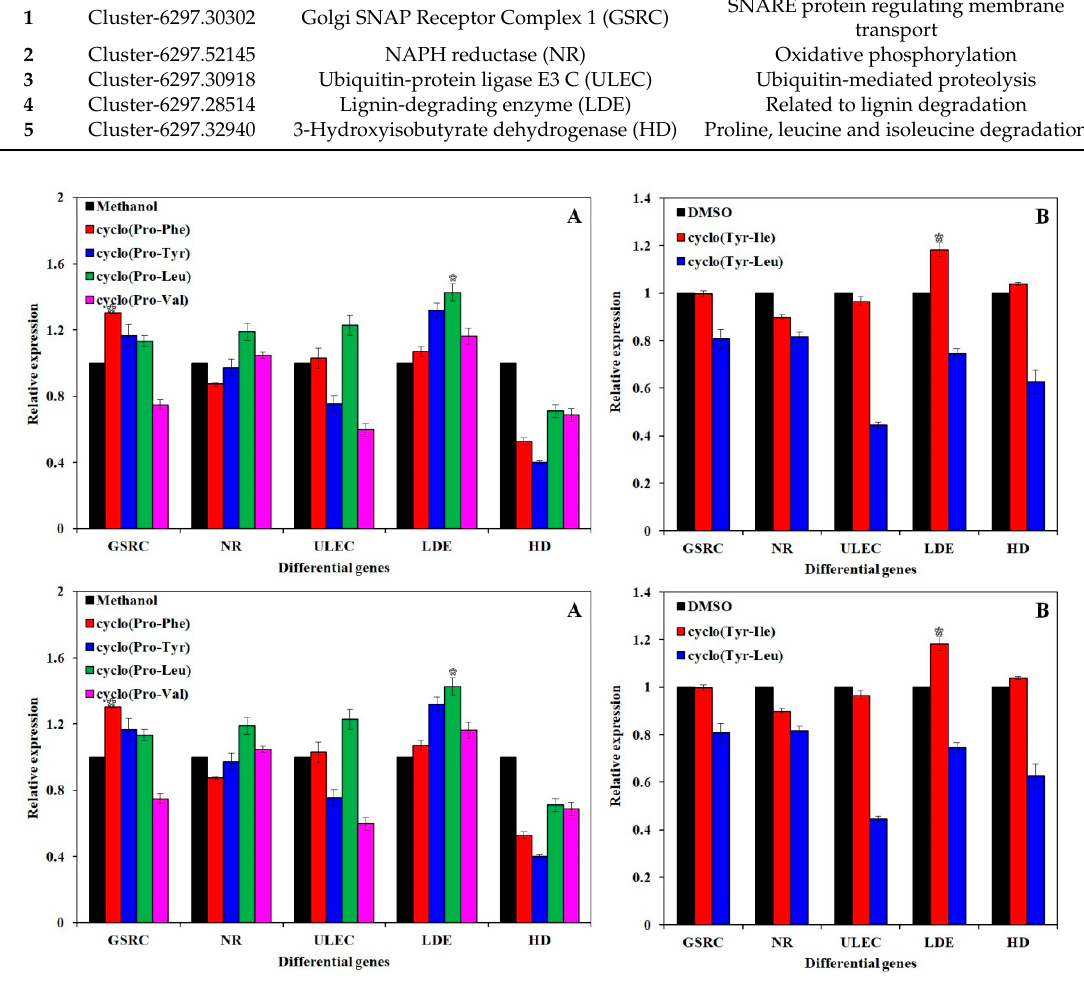
Figure 5. E ff ects of signal molecules dissolved in methanol and DMSO on the expression of di ff erential genes (Table 1) in the growth and development of H. marmoreus . ( A ) E ff ects of cyclo(Pro-Phe) (1), cyclo(Pro-Tyr) (2), cyclo(Pro-Val) (3), and cyclo(Pro-Leu) (6) dissolved in methanol on the expression of di ff erential genes; ( B ) e ff ects of cyclo(Tyr-Leu) (4) and cyclo(Tyr-Ile) (5) dissolved in DMSO on the expression of di ff erential genes. All experiments were carried out in triplicate. Bars are significantly ( p < 0.05) di ff erent from each other by T-test.